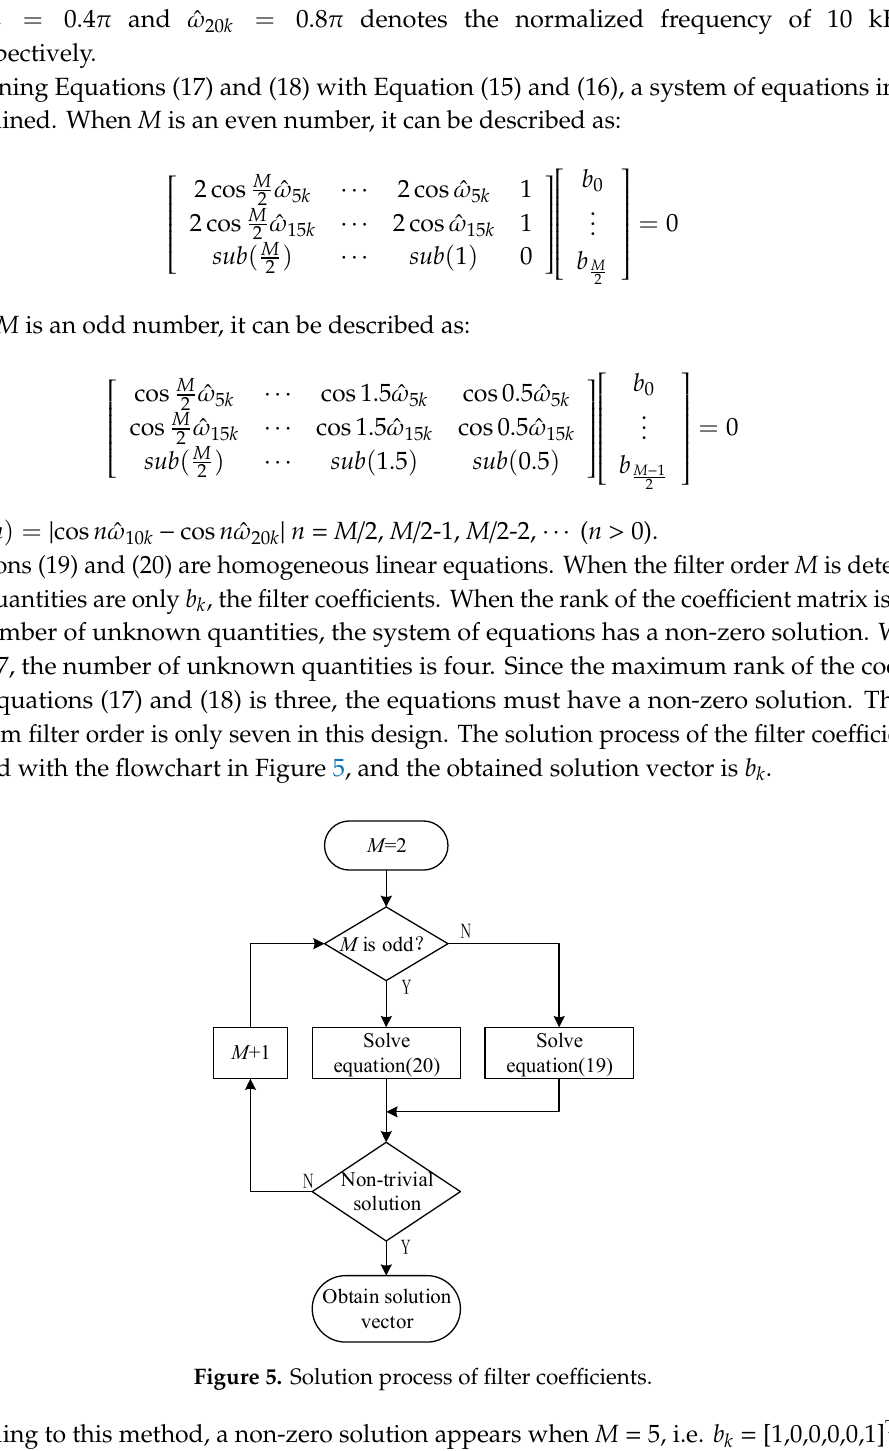
Figure 6. Amplitude–frequency response curve (left) and phase–frequency response curve (right). From Figure 6, it can be seen that the amplitude–frequency response of the filter meets the expected requirements at 5 kHz, 10 kHz, 15 kHz, and 20 kHz. Since there is no phase shift at 10 kHz and 20 kHz, the phase compensation can be omitted. In other words, the phase compensation is 0 in this design. Meanwhile, the amplitude gain of this filter at 10 kHz and 20 kHz is two. Thus, the filter output should be multiplied by 0.5 before subtraction in the process of extracting ˆ qh i . 4. Simulation and Experiment Results In order to verify the effectiveness of the FIR filter designed in this paper, simulation and experimental verification were carried out. The frequency of injection signal and the switching frequency of inverter were 5 kHz and 10 kHz, respectively. The topology of the inverter based on MOSFET was a three-phase full bridge, and the digital controller used for experiments was based on a TMS320F28335. The experiment platform is shown in Figure 7, and the parameters of PMLSM are in Table 2 and Table A.